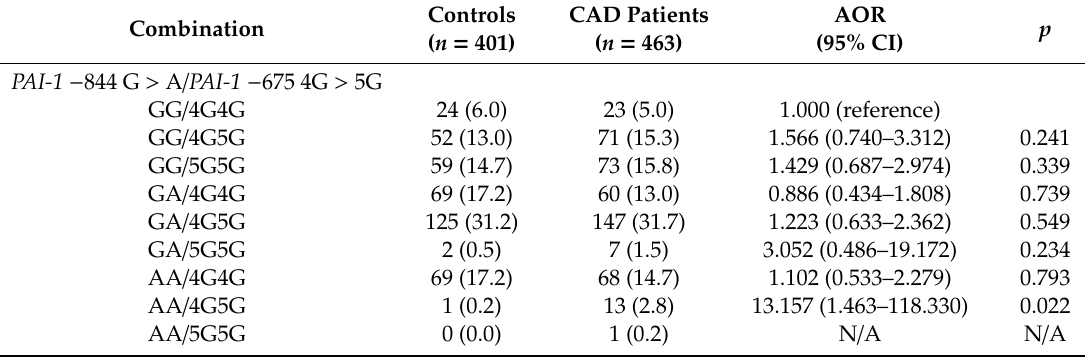
Table 5. Genotype combinations of the PAI-1 polymorphisms in coronary artery